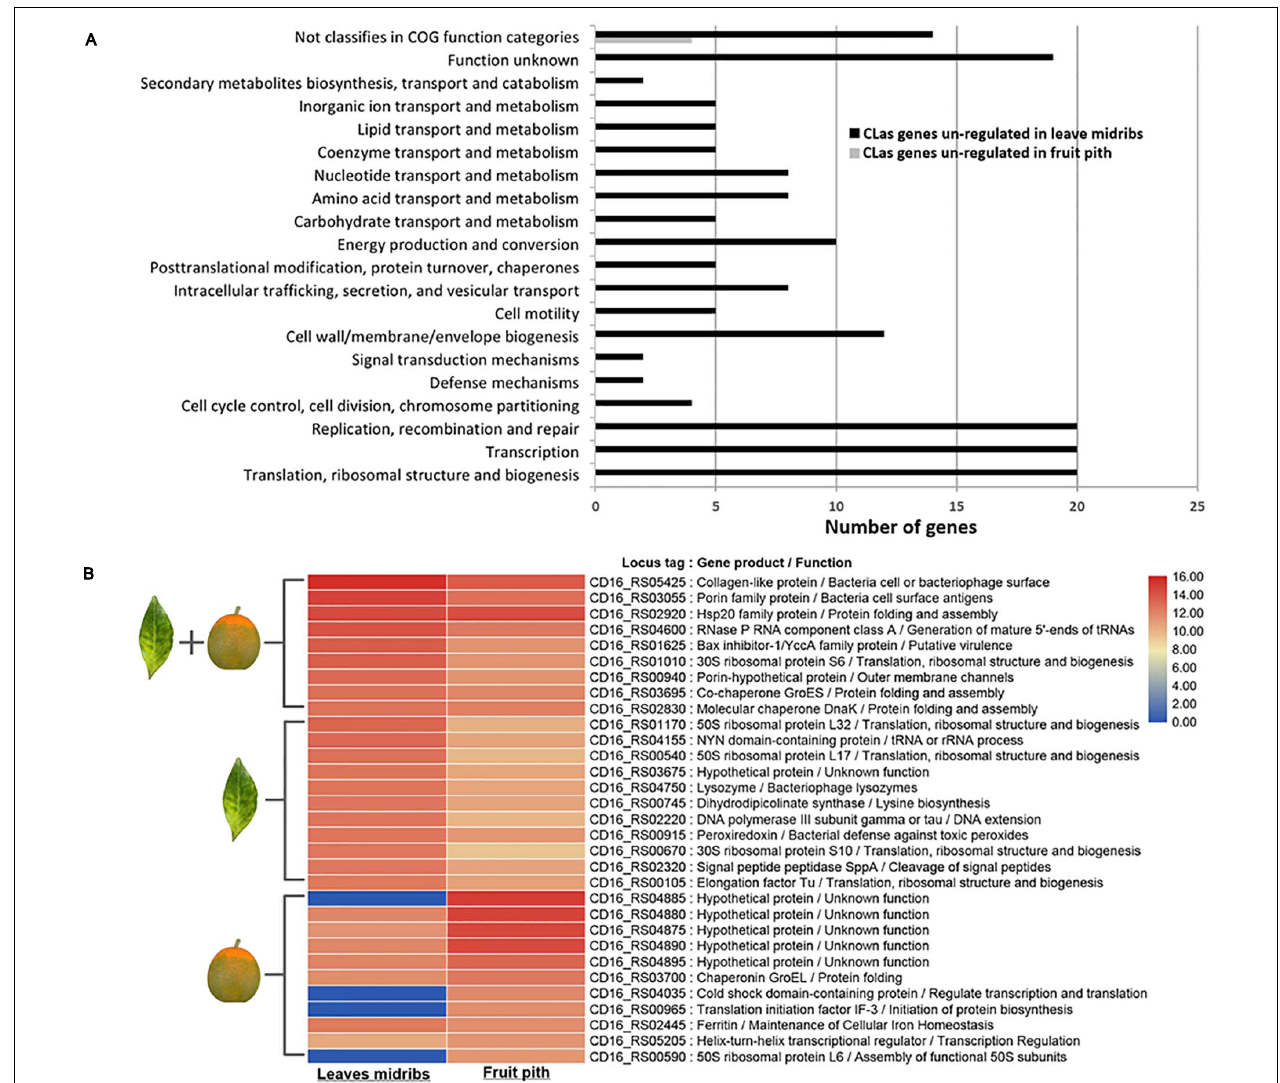
FIGURE 3 | Functional classification of differentially expressed genes (A) and top 20 highly expressed gene (B) of “ Candidatus Liberibacter asiaticus” (CLas) in fruit pith and leaf midribs. The differentially expression genes (DEGs) are identified with GFOLD v1.1.4 software by setting log2 fold change ≥ | 1 | . Classification of DEGs is performed with EggNOG v5.0 by using Clusters of Orthologous Groups database. Black bar represents genes up-regulated in fruit pith compared with leaf midribs. Gray bar represents genes up-regulated in leaf midribs compared with fruit pith. Heatmap shows the log2 of normalized TPM values for the top 20 most highly expressed CLas genes in leaf midribs tissue and fruit pith tissue. Genes that belong to the list of the top 20 most highly expressed genes in leaf midribs or fruit piths are labeled with leaf or fruit symbol in the